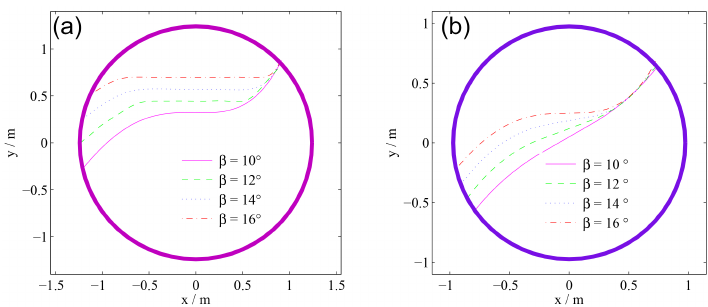
Figure 5. Shapes of the concrete with different tilt angles. (a) z = 3074mm. (b) z =